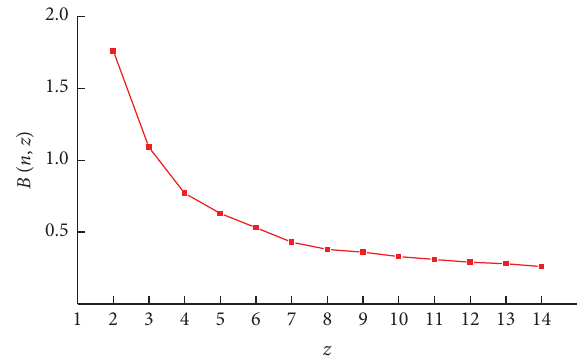
Figure 7: Objective function B ( n , z ) curve of the trafc-fow se- quence of north